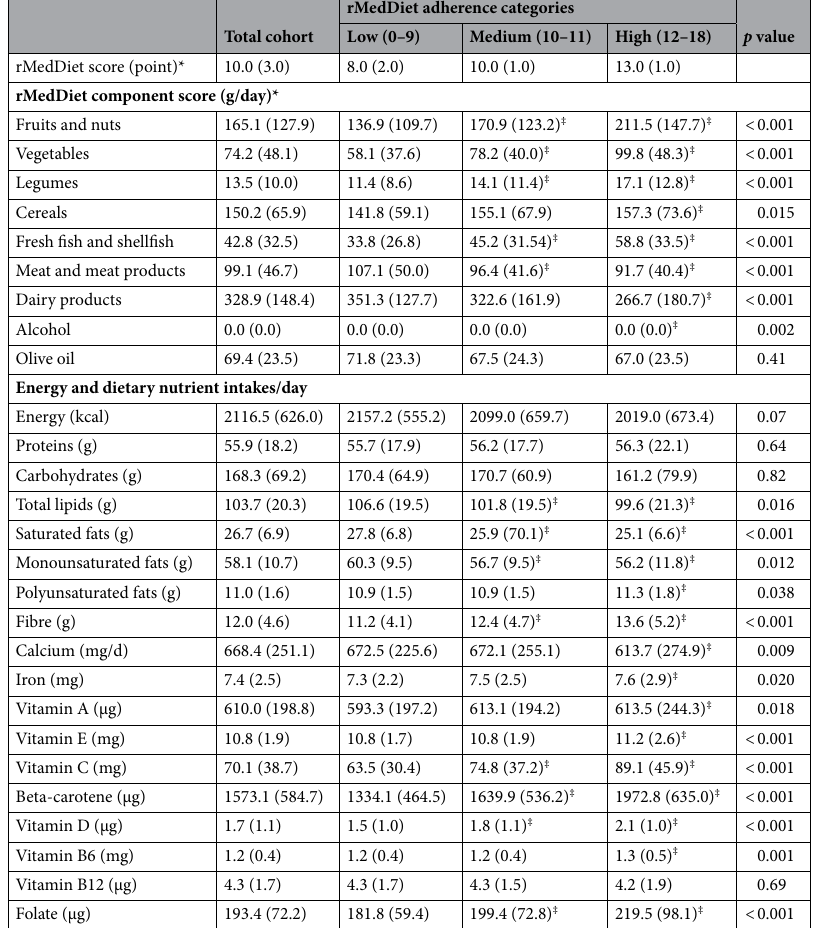
Table 2. Maternal consumption of food groups, and energy and nutrient intake according to Mediterranean Diet adherence categories during pregnancy (n = 614). *Values are expressed in median values (interquartile range). rMedDiet, Mediterranean diet. ‡ p value < 0.05 vs. low category. p values for differences across the three rMedDiet adherence categories were calculated with